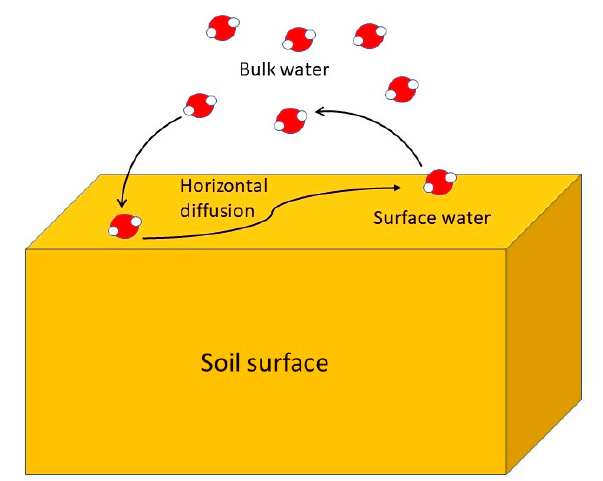
Figure 13. Bimodal water movement into soils. Surface water molecules are hooked to the soil surface being subjected to horizontal diffusion. When surface water “jumps” to the bulk, one of the bulk molecules replace it. The frequency of the “jumps” and the duration of the horizontal diffusion are affected by the strength of the interactions between water molecules and soil surface.